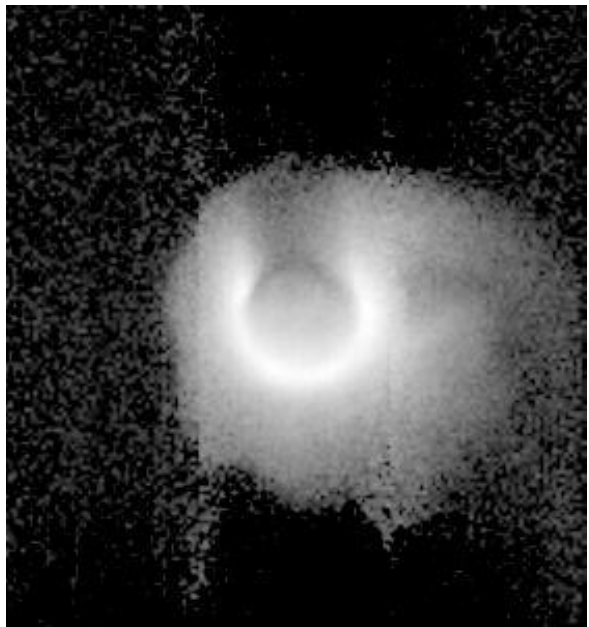
Fig. 6. IMAGE EUV image recorded at 10:32 UT (centre time) on 7 April 2001 when IMAGE was located just past apogee in the Northern Hemisphere.